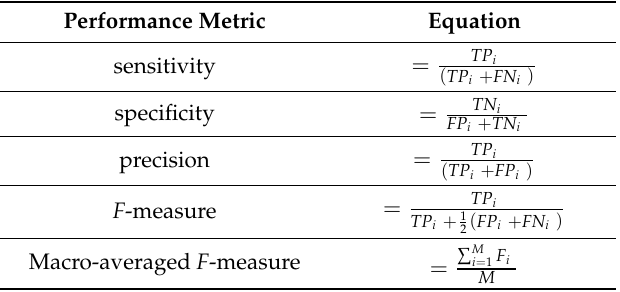
Table 4. Performance metric equations used in model assessment. The index i is the behaviour event, TP = true positive, TN = true negative, FP = false positive, and FN = false negative. M is the number of behaviour